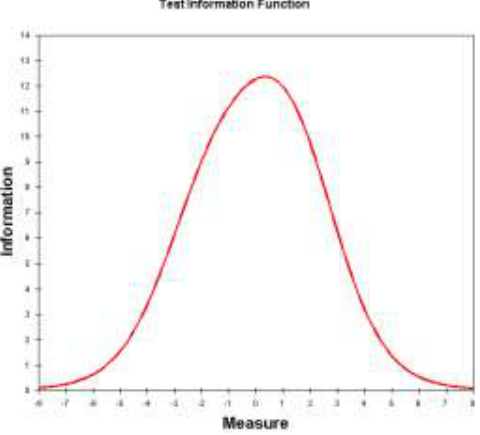
Figure 1. Test Information Function